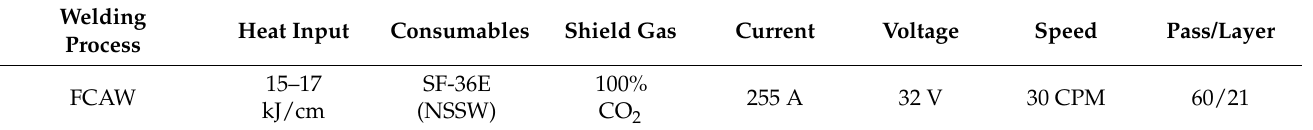
Table 2. Welding conditions at 70 mm thickness.